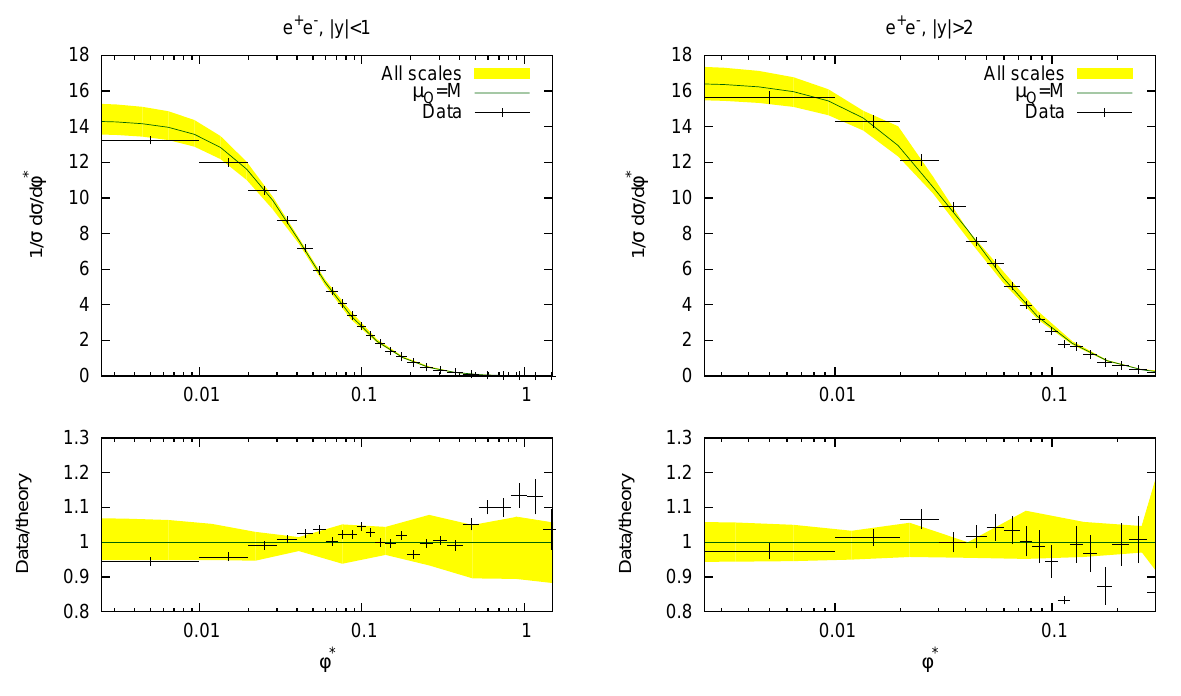
Figure 1. Comparison of the theoretical NNLL + NLO prediction [25] for the φ ∗ distribution to the experimental data collected by the DØ collaboration [22], in di ff erent rapidity bins.